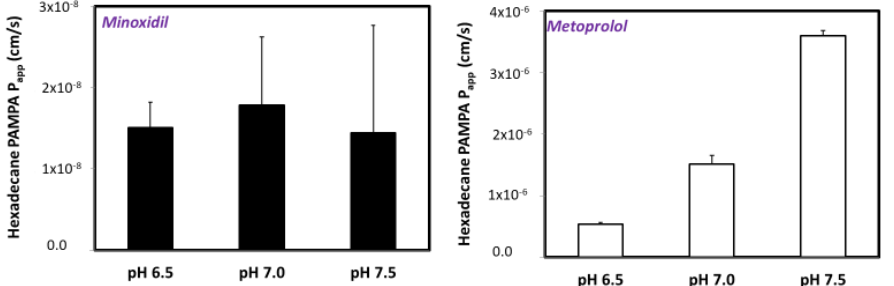
Figure 3. The apparent permeability ( P app ; cm/s) obtained for minoxidil and metoprolol at the three pH values 6.5, 7.0, and 7.5 in the hexadecane PAMPA experiments. Data are presented as the mean ± SD; n = 4 in each experimental group.